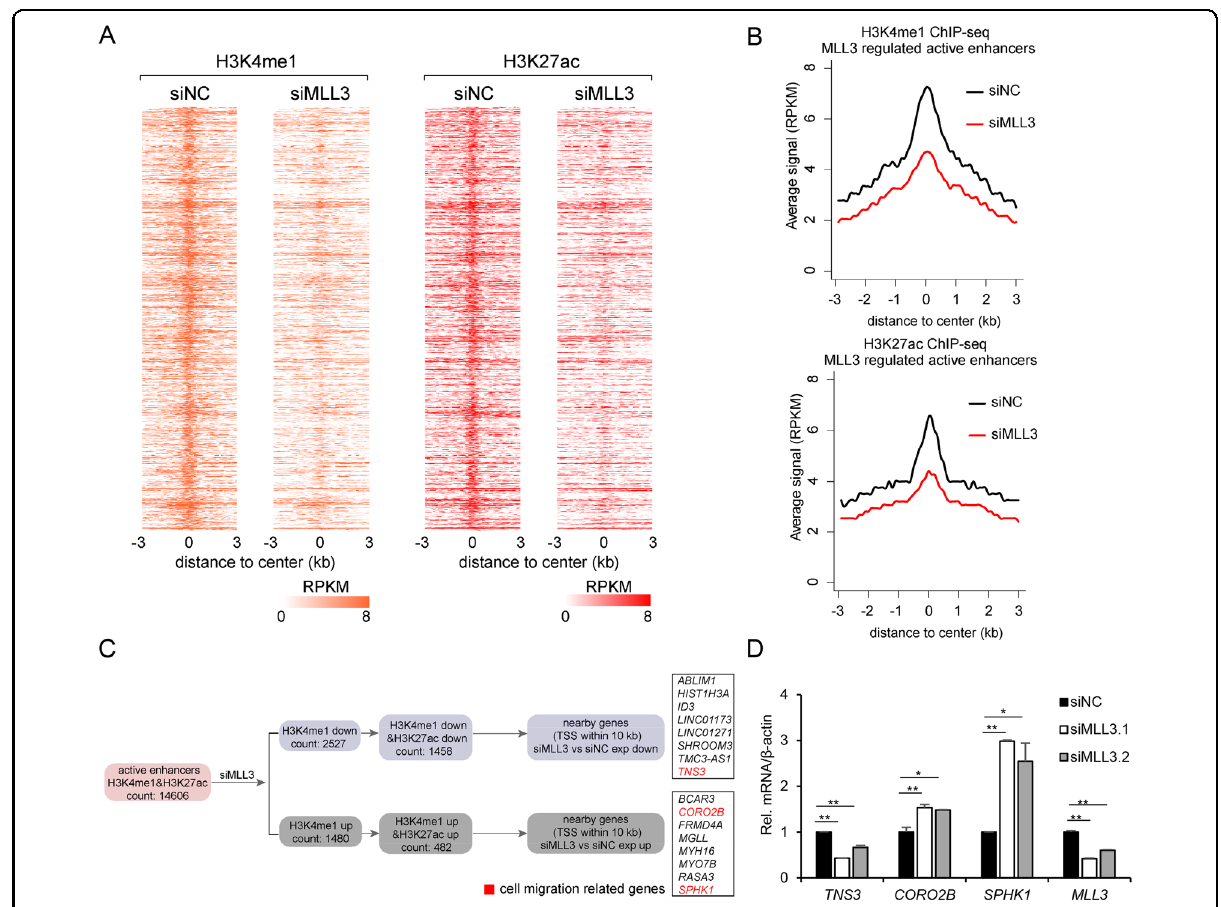
Fig. 3 ChIP-Seq analysis to identify MLL3 target genes. A Heatmaps showing H3K4me1 and H3K27ac signals (RPKM) over 1458 MLL3 regulated active enhancer regions in siNC and siMLL3 cells. Heatmaps are sorted by the strength of H3K4me1 signals. B Aggregate plots comparing the average signals (RPKM) of H3K4me1 and H3K27ac on the enhancer regions in ( A ). C A sketch map showing the pipeline to identify enhancers regulated by MLL3 and their nearby genes. Genes related to cell migration are highlighted in red. D Veri fi cation of the expression of red highlighted genes in ( C ) after MLL3 knockdown by qRT-PCR. Histograms show the relative mRNA fold change presented as mean± SD ( n = 3). * P <0.05, ** P <0.01, *** P